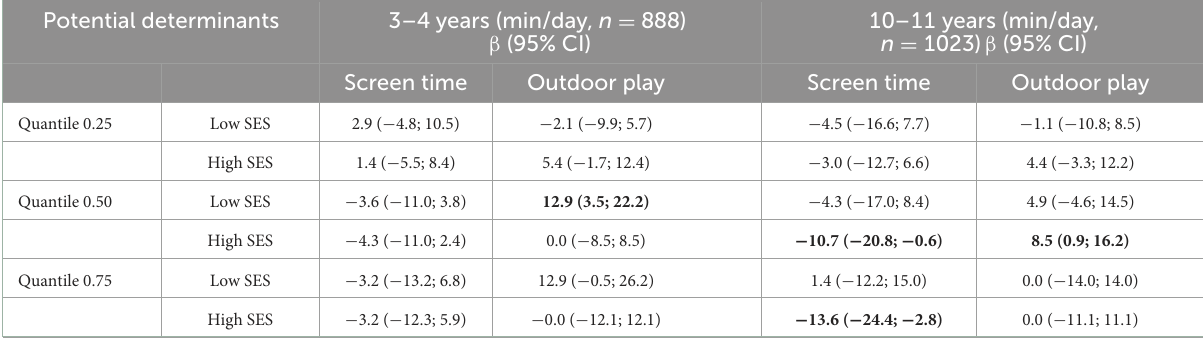
TABLE 2 The estimated regression coefficients in screen time and outdoor play according to the level of socioeconomic status. Potential determinants